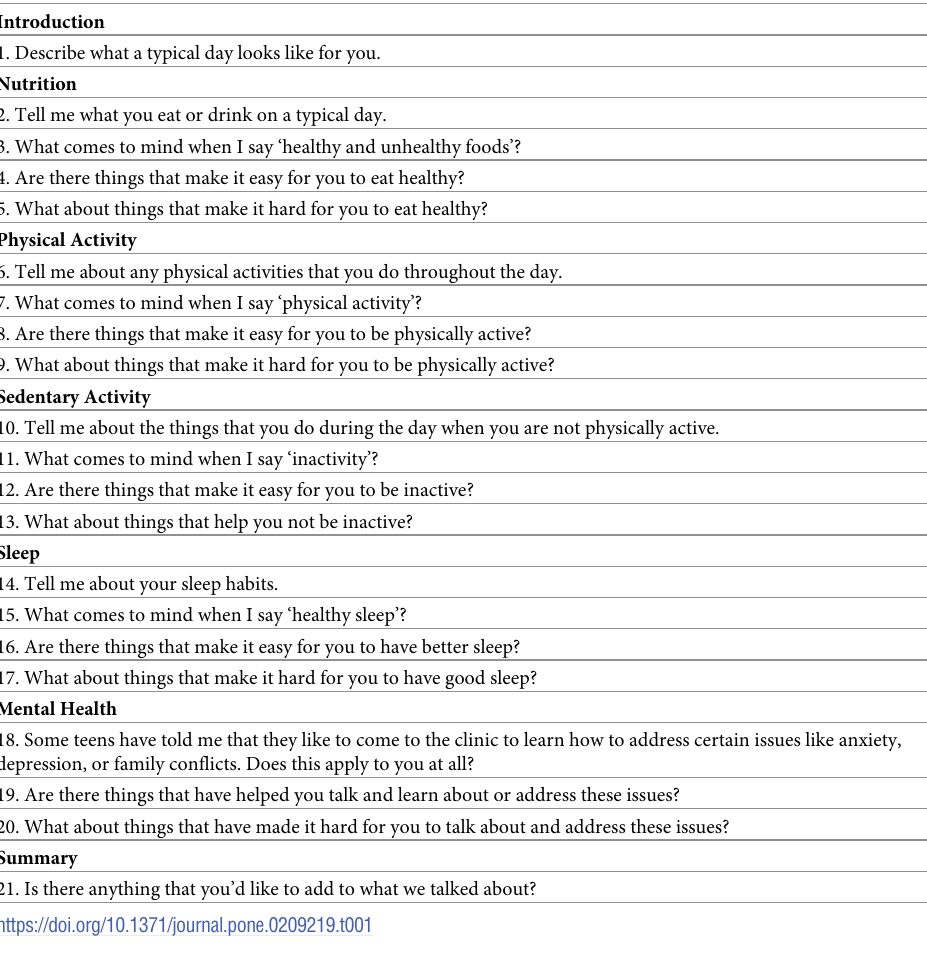
Table 1. Interview guide exploring barriers to and enablers of adopting healthy lifestyle behavior changes by ado- lescents with